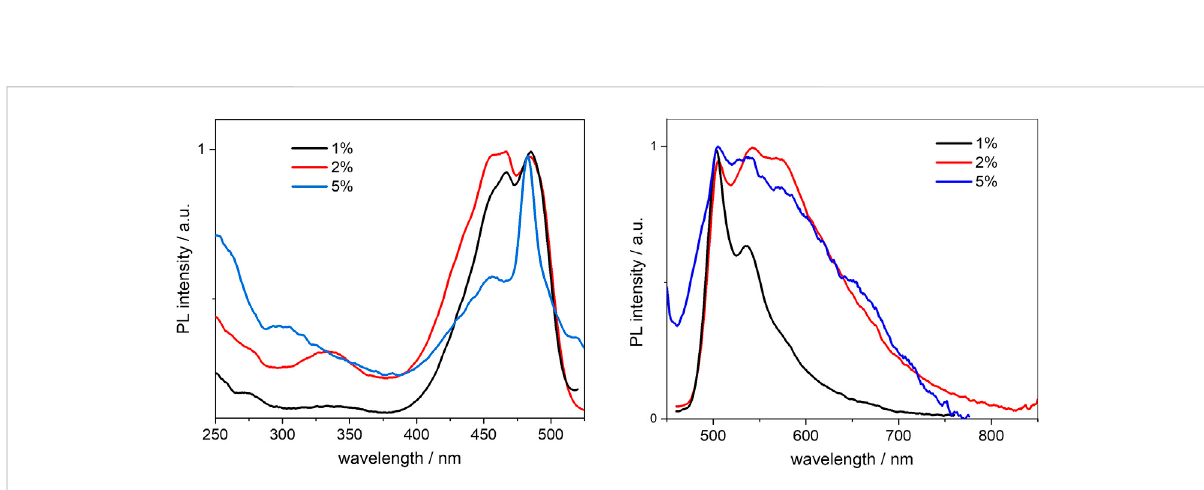
FIGURE 8 Normalised excitation (left) and emission (right) spectra of the BOPHY2-PMO samples, recorded from 0.3 mg/ml cyclohexane suspensions at λ λ em = 540 nm and exc = 420 nm,